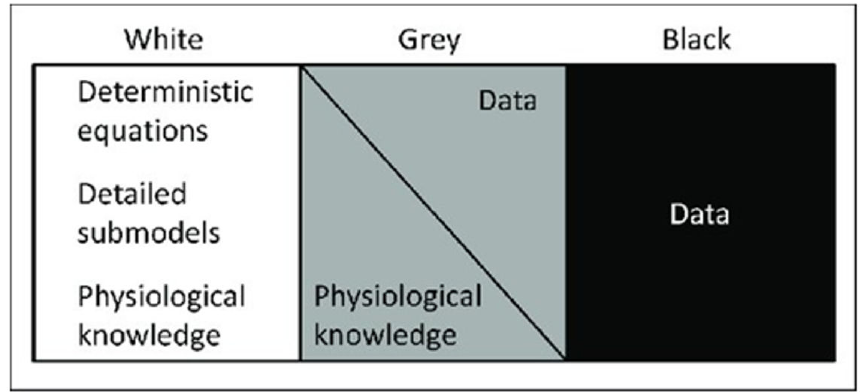
Figure 2. Grey-box